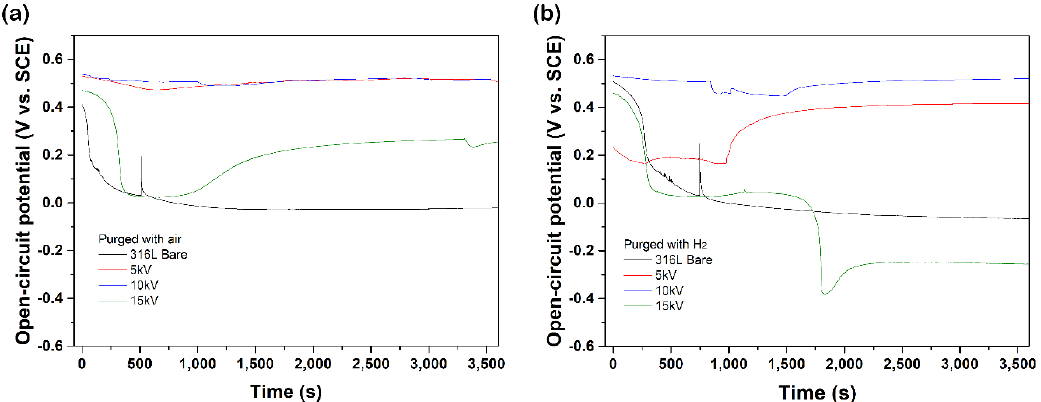
Figure 4. Open circuit potential curves of N + -implanted samples in 0.5 M H 2 SO 4 at 70 °C with purged ( a ) air and ( b ) H 2 .